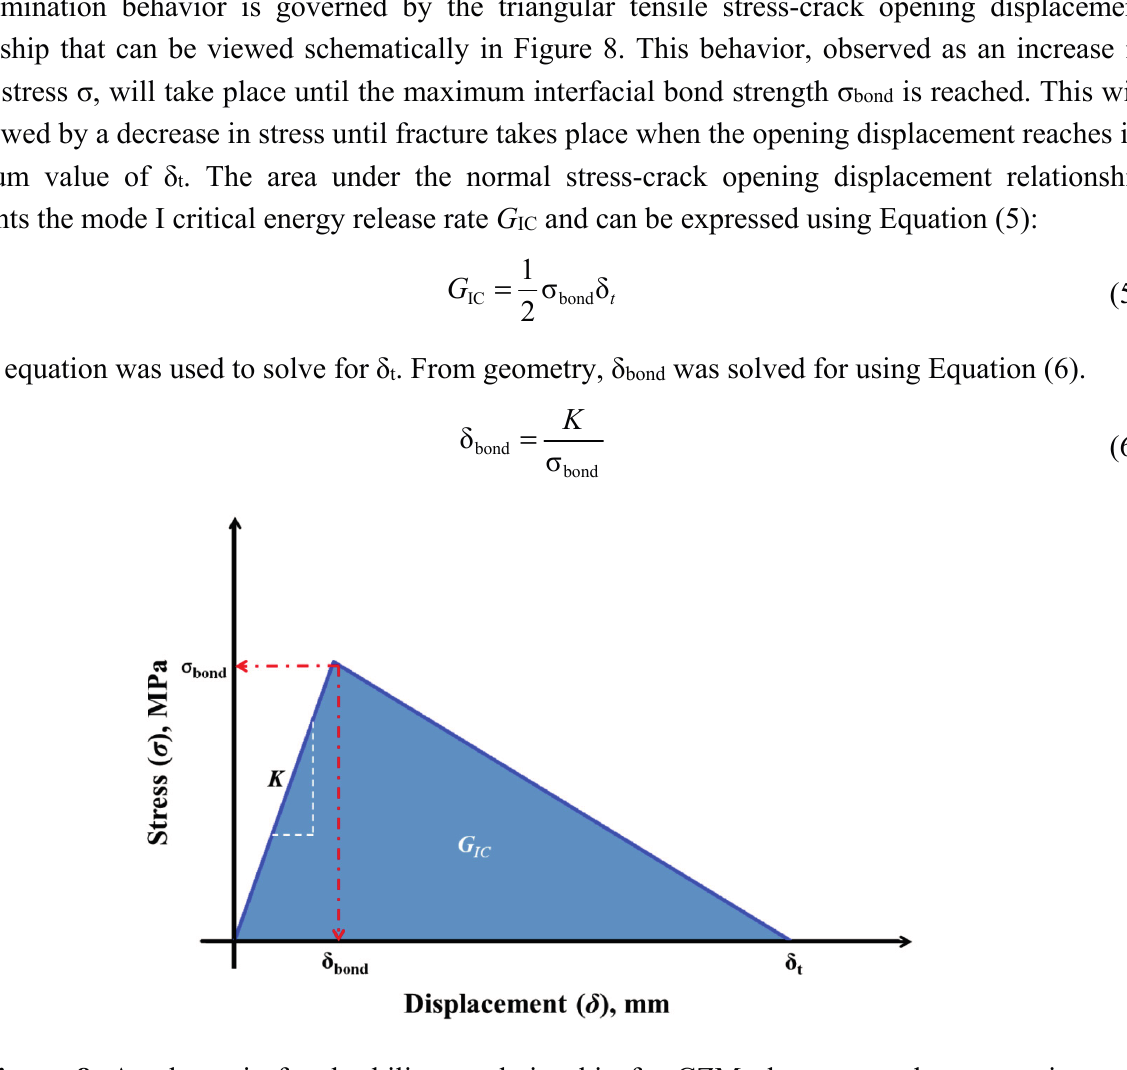
Figure 8. A schematic for the bilinear relationship for CZM elements at the composite laminate